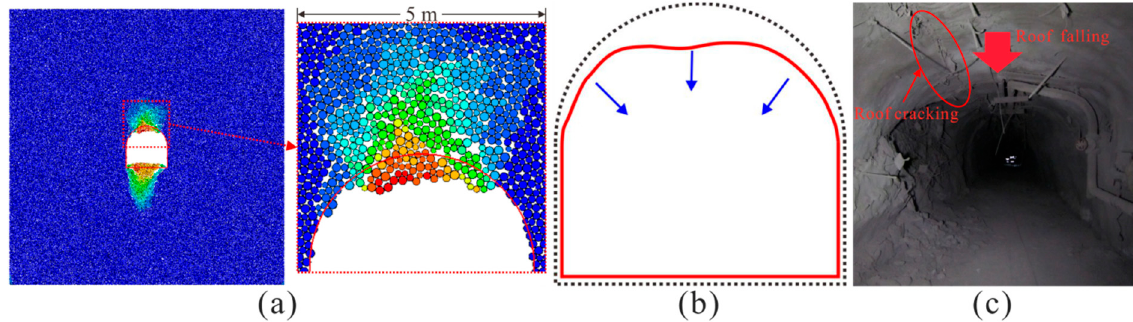
Figure 10. Schematic diagram of pressing roof failure. ( a ) Numerical simulation result; ( b ) Failure mechanism; ( c ) Field representation.